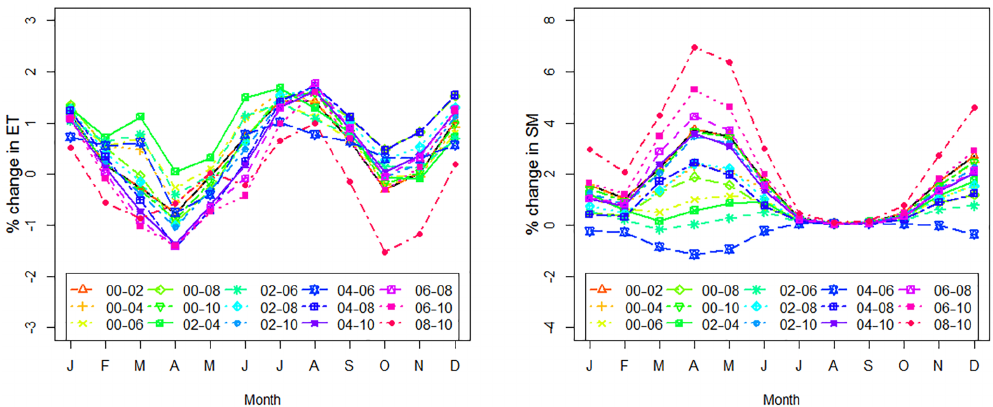
Figure 9. Percent change in evapotranspiration and soil moisture climatologies when running JULES with each of the 15 different future projections of land use, relative to the 2010 land-cover map. The meteorology was held fixed, so that only the impact of land-use change can be